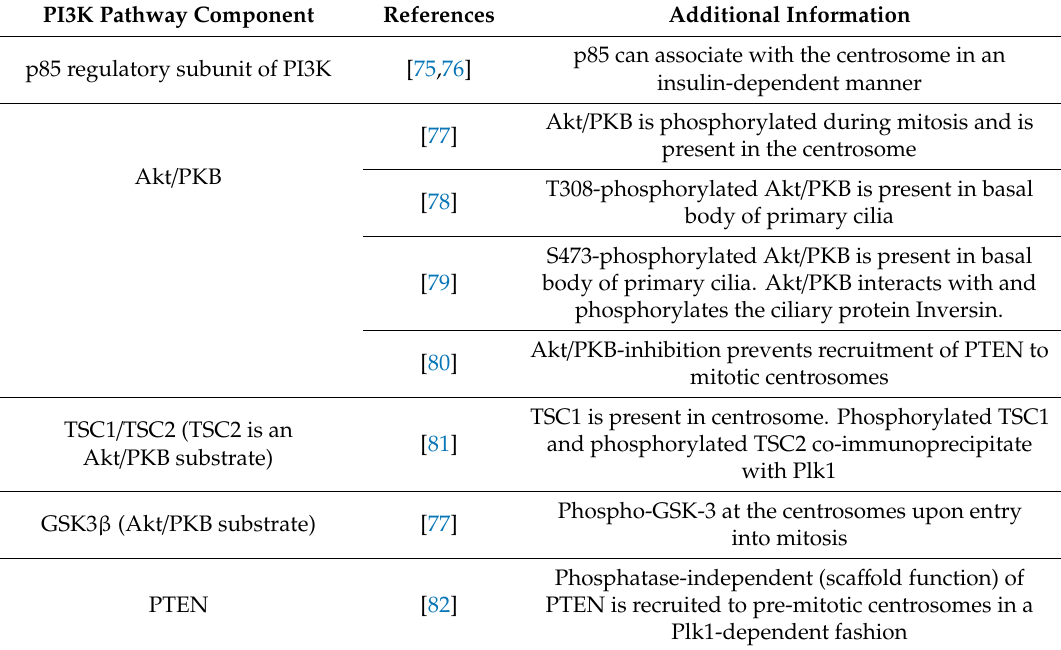
Table 1. PI3K pathway components found in centrosome / primary